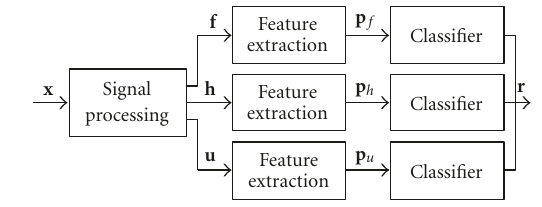
Figure 5: Standard paradigm for the classification of single and multiple disturbances.